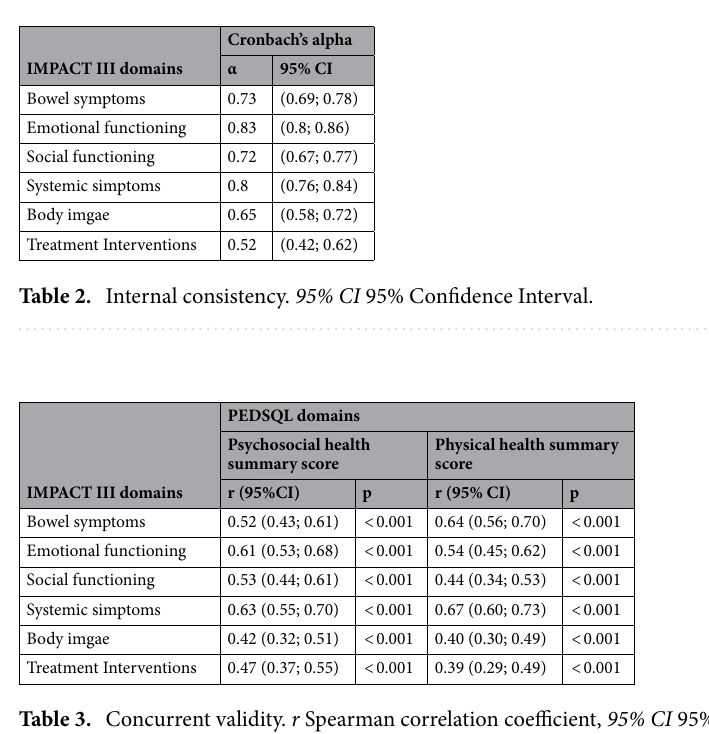
Table 3. Concurrent validity. r Spearman correlation coefficient, 95% CI 95% Confidence interval, p refers to Spearman correlation